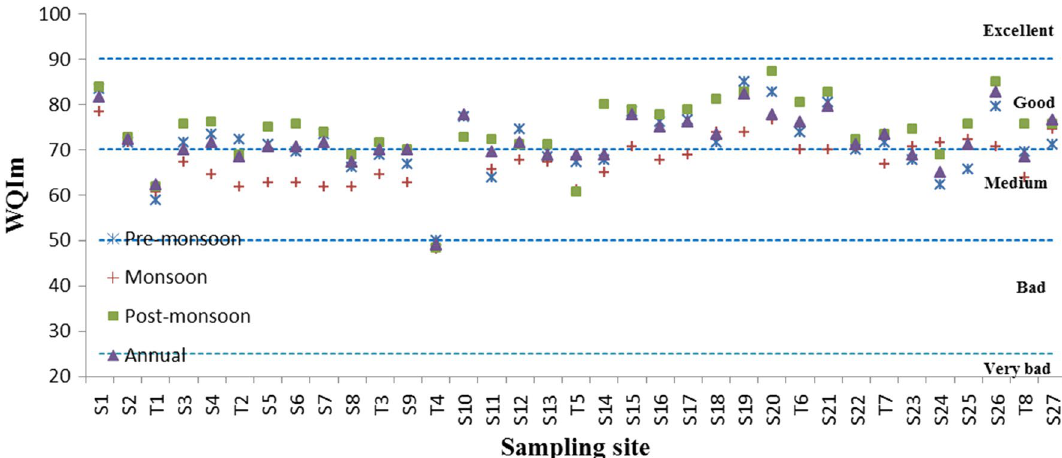
Fig. 8 Spatial and temporal variations of WQI